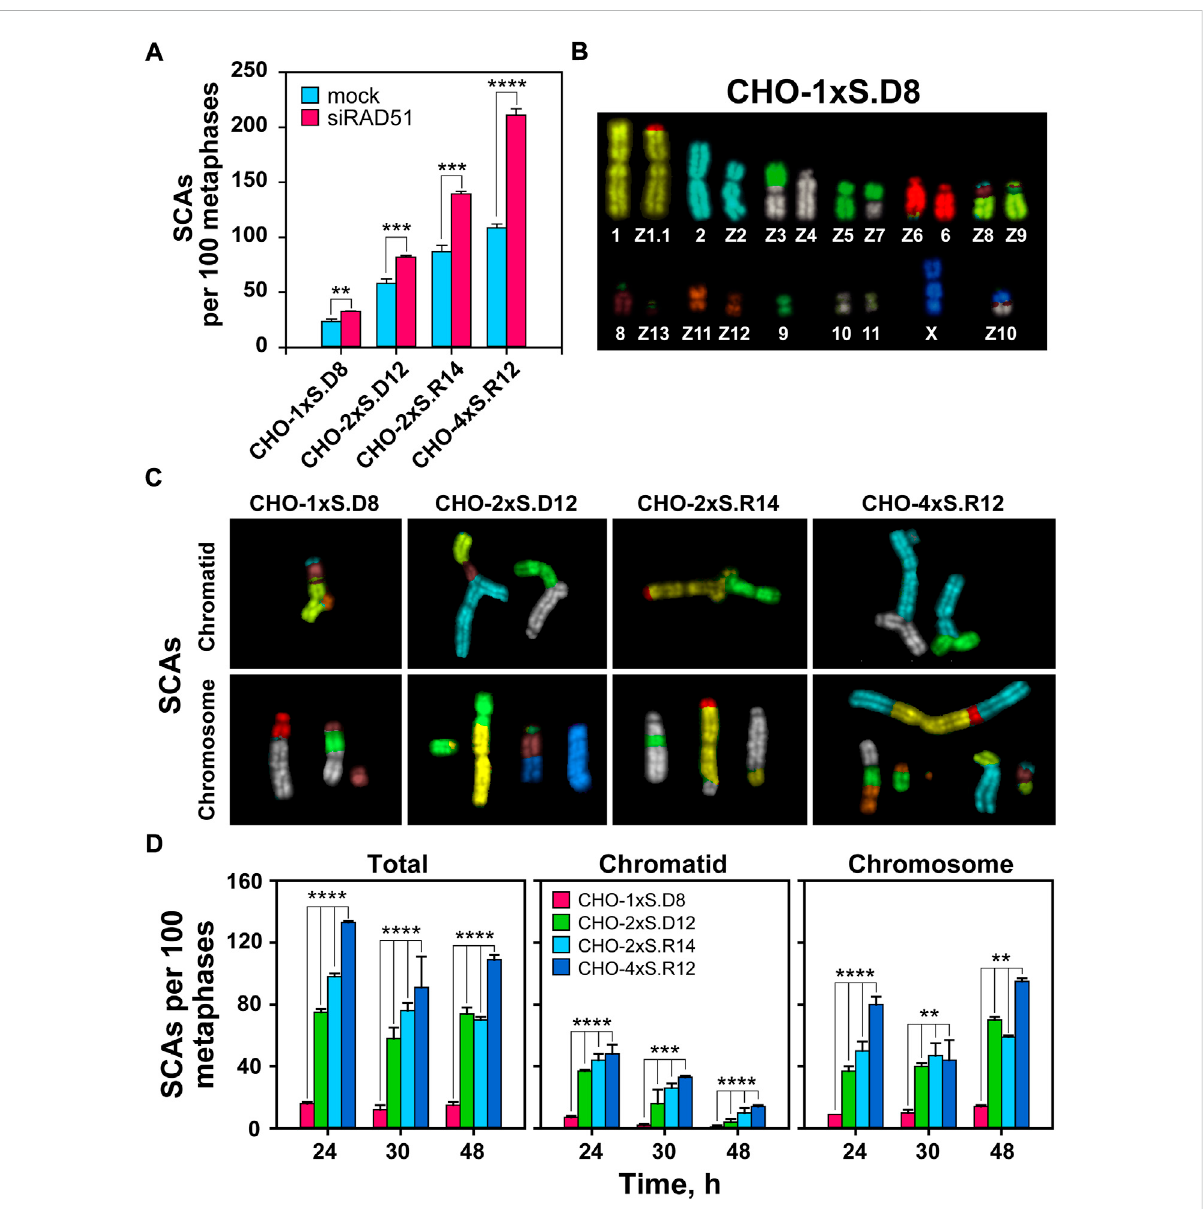
FIGURE 4 mFISH analysis of SCAs following induction of single and clustered DSBs. (A) QA of SCAs scored 24 h after I-SceI transfection in RAD51- depletedCHOclones. (B) mFISHkaryotypeofCHO-1xS.D8cells.Note:thekaryogramsofundamagedchromosomesinallCHOclonesareidentical withthekaryogramofCHO10B4cells. (C) Representativeimagesofchromatid-andchromosome-typeSCAscaptured24 hafterI- Sce Itransfection. (D) QA of chromatid and chromosomal abnormalities scored at the indicated times after transfection of the indicated CHO clones. The numbers of SCAs scored in mock-transfected cells have been subtracted from the results presented. At least 100 metaphases are scored per metaphase spread. Data represent means and standard deviations (±SD) from three independent experiments. (ns, no signi fi cance, p > 0.05); (* p ≤ 0.05); (** p ≤ 0.01); (*** p ≤ 0.001); (**** p ≤